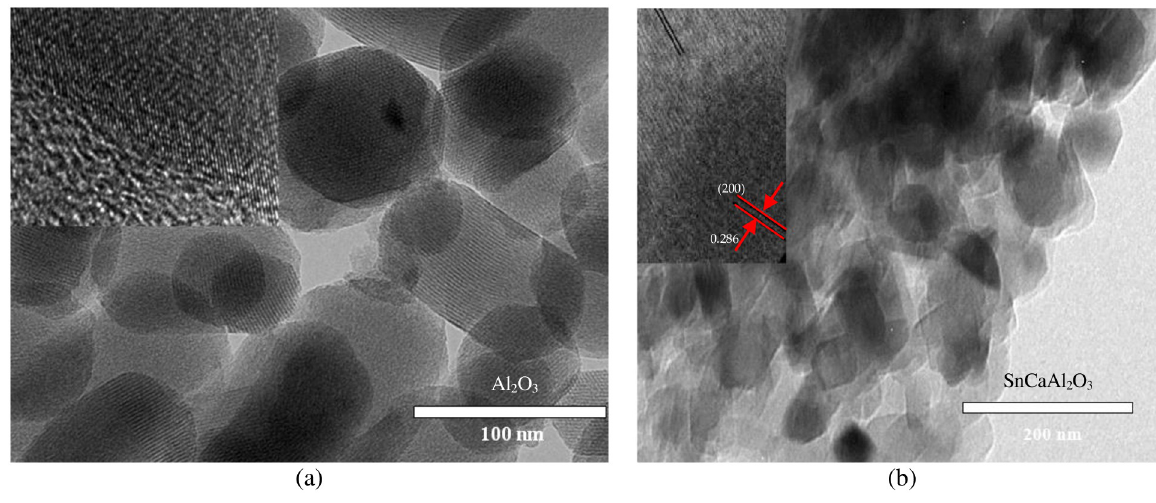
Fig 4. T.E.M. image of Al 2 O 3 (a) and SnCaAl 2 O 3 (b) nanoparticles.